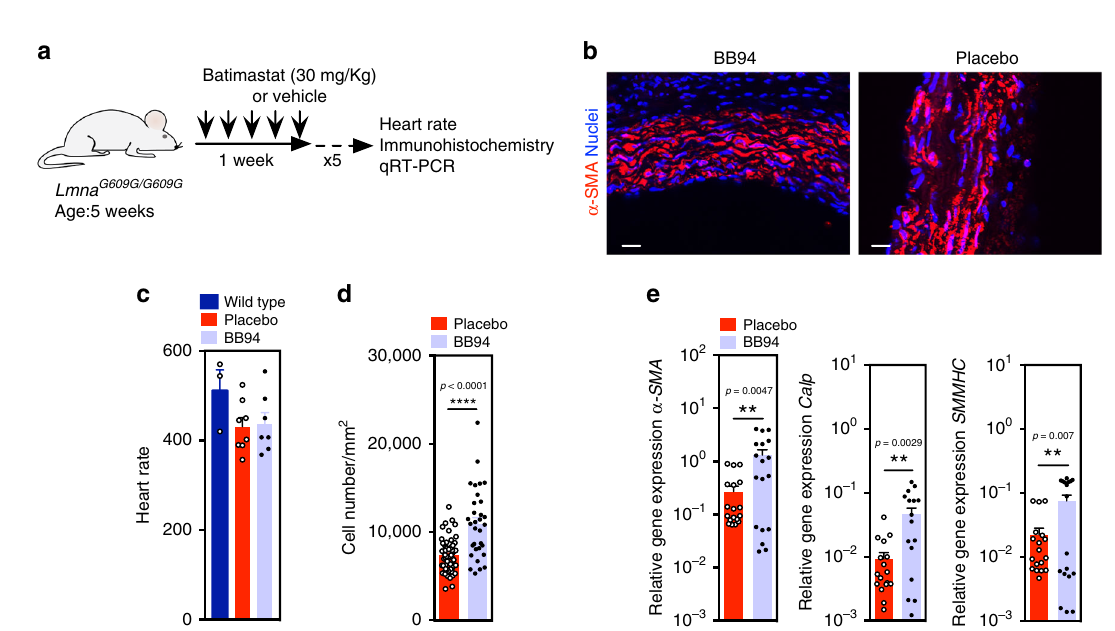
Fig. 7 MMP treatment using BB94 signi fi cantly increases SMC number in aortic arch of Lmna G609G/G609G mice. a Schematic representation of the animal protocol. Lmna G609G/G609G mice ( n = 8 for treatment group and control group; age: 5 weeks) were IP injected fi ve times a week (30 mg/kg/day; 3 mg/mL in PBS). b Immuno fl uorescence analyses performed on mouse SMC for α -SMA showing higher number of SMCs in treated aortic arch. Cell nuclei were stained with DAPI. SMCs were stained for α -SMA. Scale bar is 100 µ m. For BB94 treatment n = 5 animals. For placebo treatment n = 7 animals. c Heart rates in mice. Wild-type mice were not exposed to BB94. n = 3 for wild-type mice, n = 8 for placebo treatment group and n = 7 for BB94 treatment group. d Number of SMC nuclei in aortic arch per tissue area (mm 2 ) in mice treated or not with BB94. For BB94 treatment, n > 6 images examined over fi ve animals. For placebo treatment, n > 9 images examined over seven animals. e Expression of SMC genes in aortic arches of mice treated or not with BB94. Gene expression was normalized by the housekeeping gene GAPDH . n > 3 technical replicates over six animals. **, ***, **** denote statistical signi fi cance ( p < 0.01, p < 0.001, p < 0.0001). Statistical analyses were performed by a two-tailed unpaired Student ’ s t test d and e